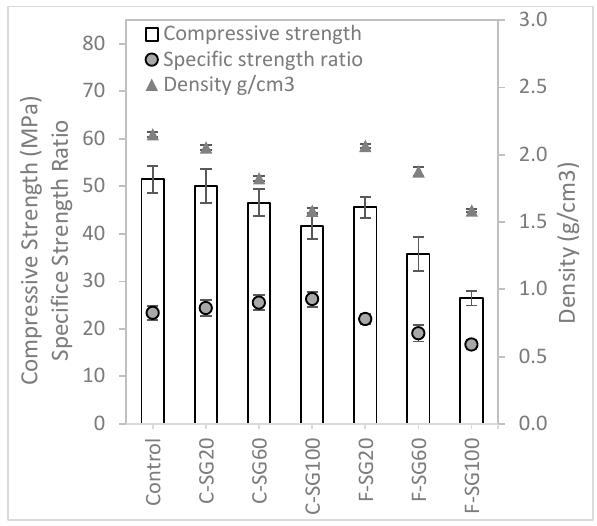
Figure 7. Compressive test results of mixtures prepared with the speci fi c gravity method.